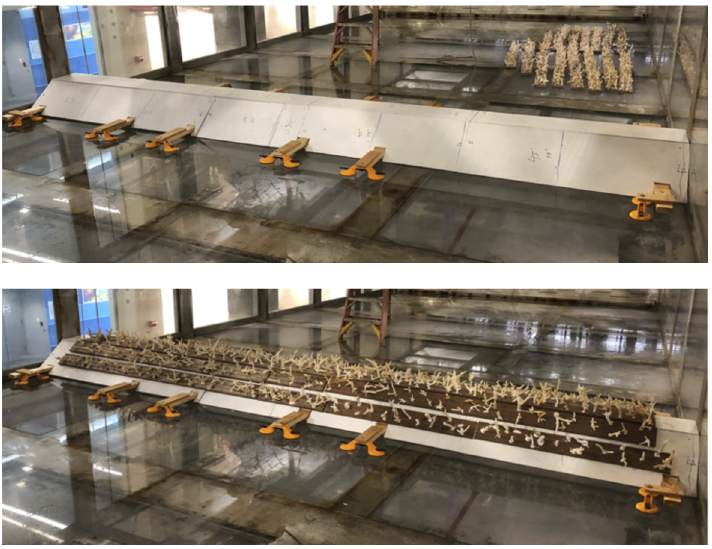
Figure 2. Top: the reef model in its breakwater-only configuration in SUSTAIN. Bottom: the reef model with staghorn coral skeletons in